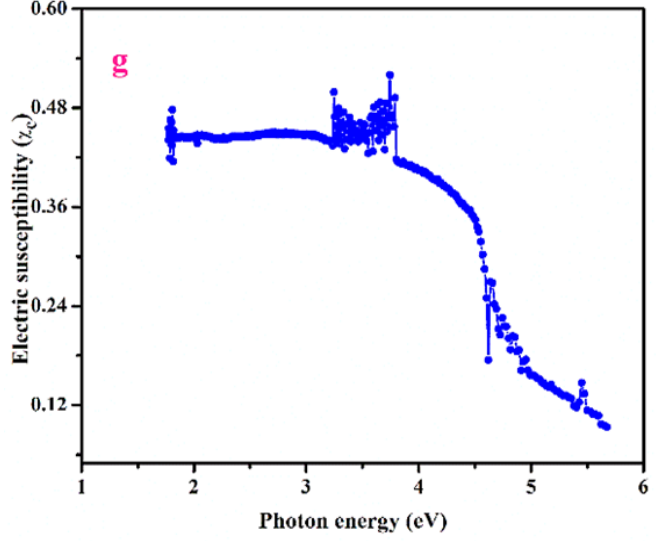
Figure 4. Variation of reflectance and extinction coefficient vs. (i) photon energy ( a , b ), (ii) absorption coefficient (α) ( c , d ). Plot of photon energy vs. (i) refractive index (n 0 ) ( e ). (ii) electrical conductivity and optical conductivity ( f ) (iii) Electric susceptibility (χ c ) ( g ).